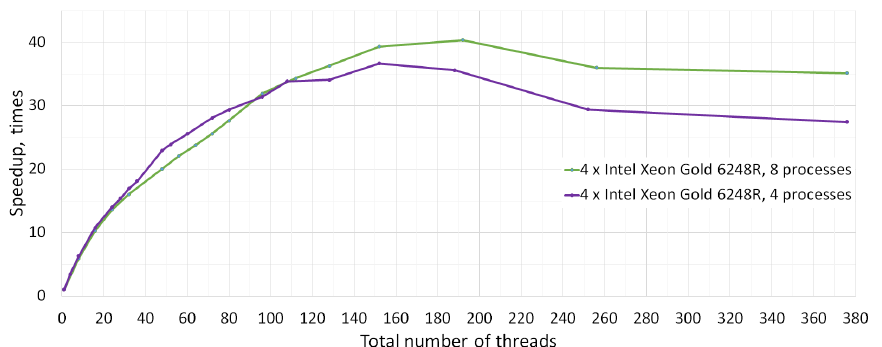
Figure 7. Speedup of four-node executions of the inverse problem solution with four (one per two-CPU node) and eight (two per node with CPU affinity) MPI processes. For a large number of threads, the option with CPU affinity provides better results despite the additional costs of duplicating